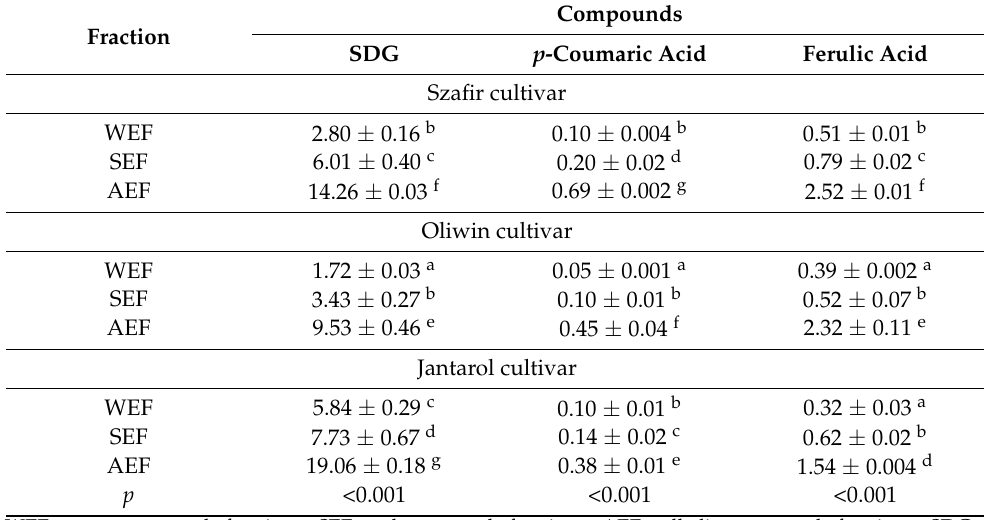
Table 2. SDG and phenolic acid content (mg g − 1 ) in the flaxseed protein fractions. Compounds Fraction SDG p -Coumaric Acid Ferulic Acid Szafir